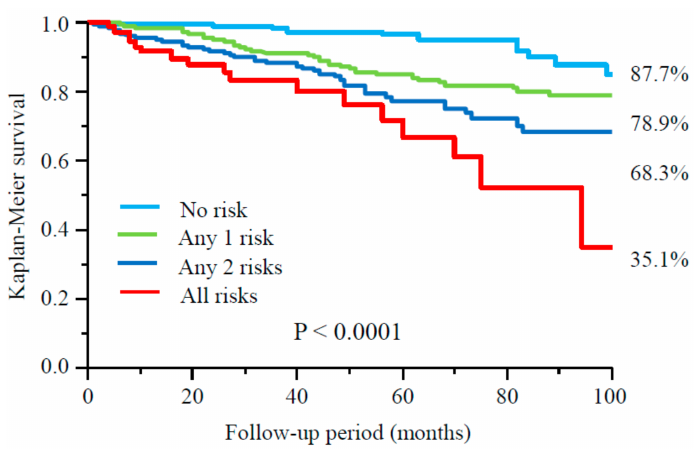
Figure 1. Cardiovascular survival among groups according to number of risk factors, abnormal ABI, GNRI, and CRP.